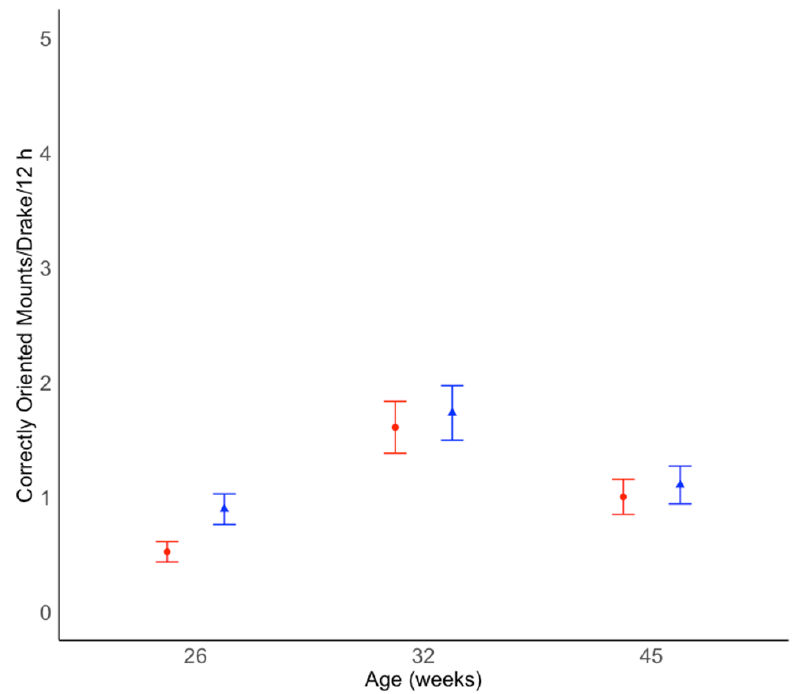
Figure 2. Average number of correctly oriented mounts for Pekin drakes over three 12 h observation periods at 26, 32, and 45 weeks of age for same sex rearing groups and mixed sex rearing groups. Mount rate values differed by age ( p < 0.001) but not treatment. Mount rate values are presented as estimated marginal means and standard errors.